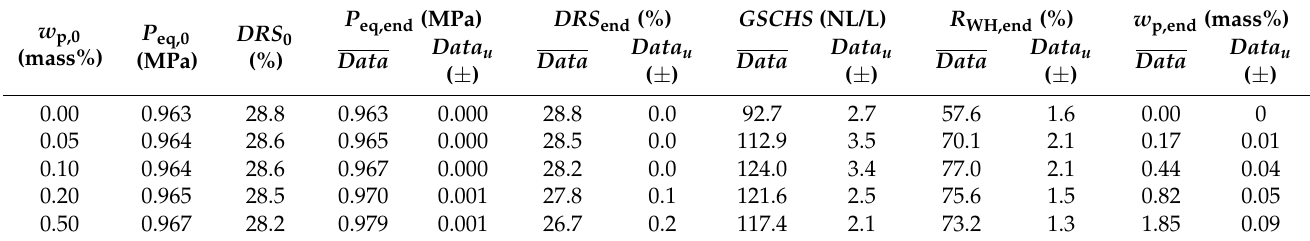
Table 2. The effect of the w p,0 on the final state of ethylene hydrate